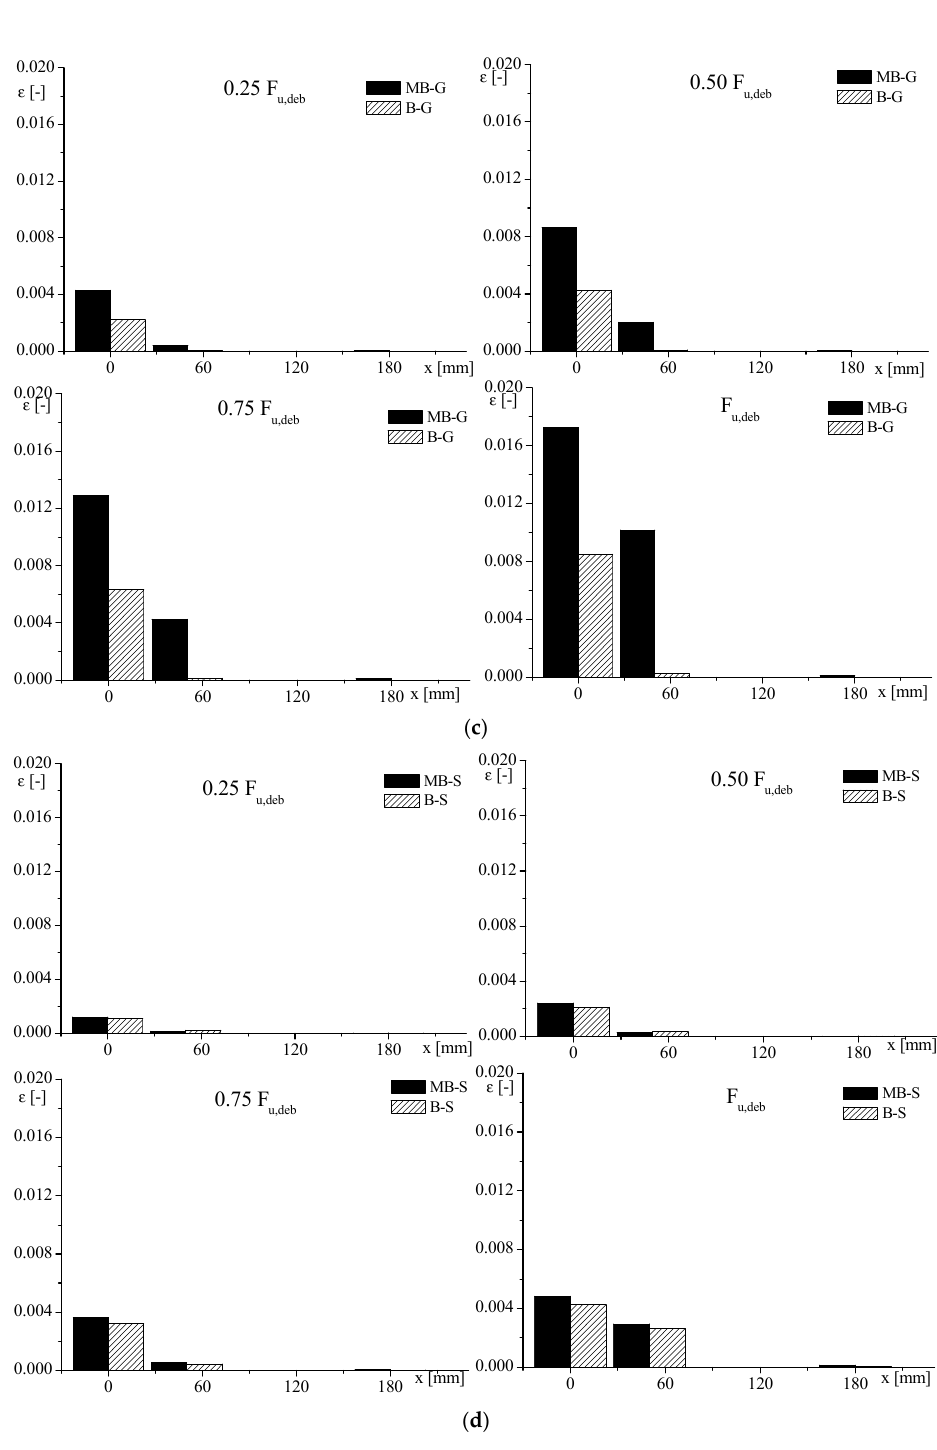
Figure 9. Strain–position values of clay unit and clay masonry unit with ( a ) BFRP-1; ( b ) CFRP-1; ( c ) GFRP; ( d ) SPR.